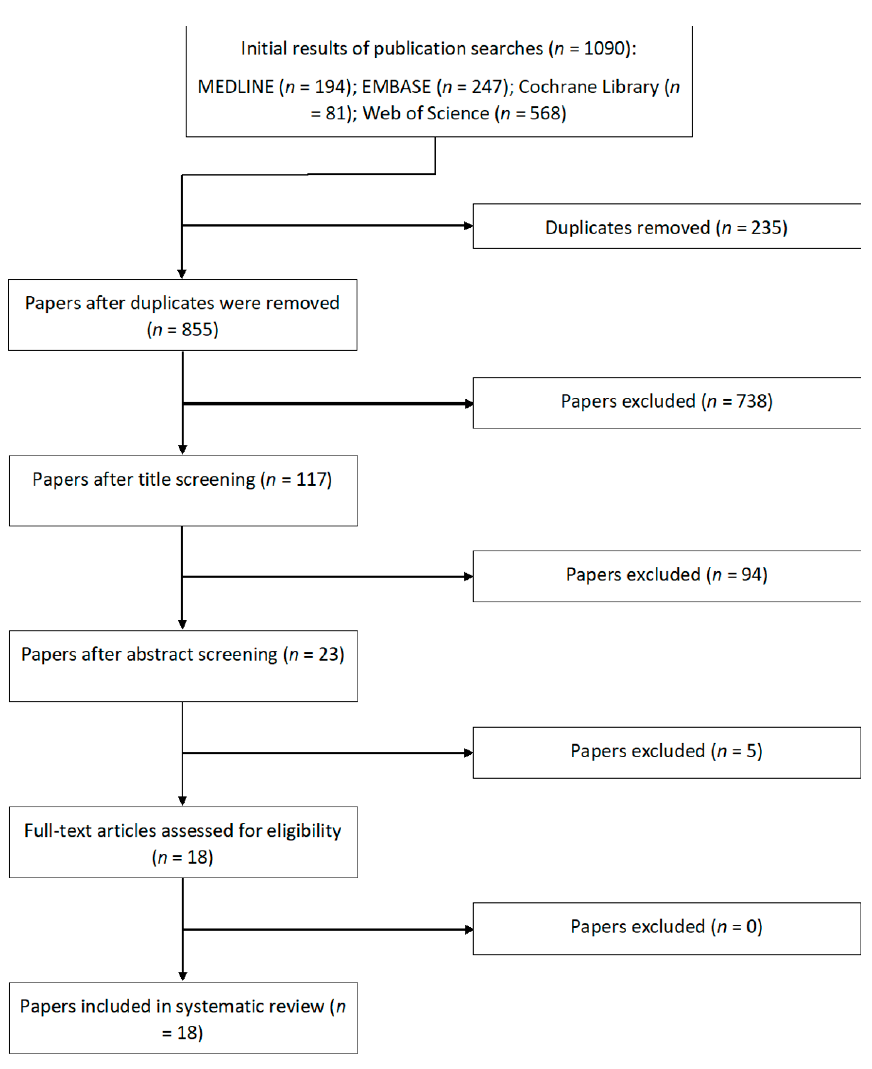
Figure 1. Overview of the screening and selection process of studies for the systematic review.